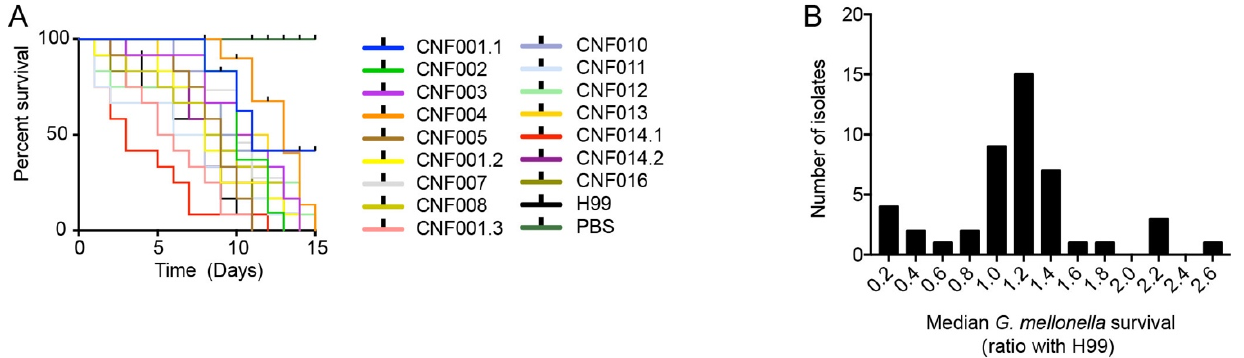
Figure 7. G. mellonella survival after infection with different C. neoformans isolates. ( A ) Survival curves of G. mellonella infected with clinical isolates. In this experimental batch, all isolates were C. neoformans of the molecular type VNI. ( B ) Frequency distribution of the median survival G. mellonella infected with clinical isolates ( n = 46). Twelve larvae were infected per isolate.